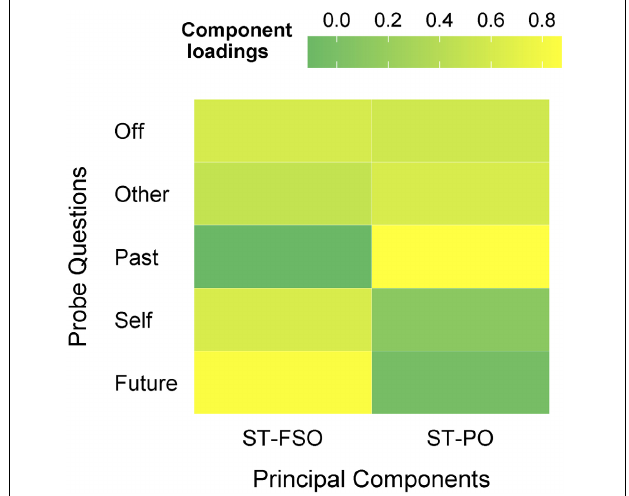
FIGURE 2 | PCA on SGT ratings revealed two Principal components, one loading positively on Off-task, Future, Self and Other ratings (ST-FSO) and one loading positively on Off-task, Past and Other (ST-PO). PCA with Varimax Rotation was applied on 1200 thought probes i.e., regrouping probes from both tasks and all participants.